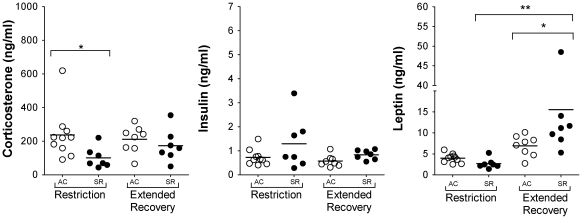
Mean basal plasma corticosterone, insulin, and leptin concentrations in individual ambulation control (○) and sleep-restricted (•) rats without and with an extended recovery period.Horizontal bars indicate group means for each treatment condition. Significance of *P<0.03 and **P<0.001 are between-group differences during sleep restriction or ambulation control treatments indicated by brackets.